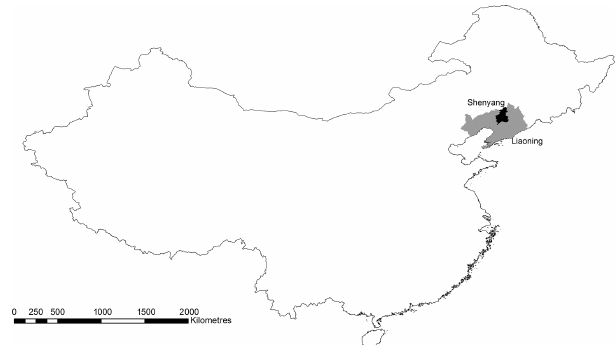
Figure 1. The geographical location of Shenyang, Liaoning Province, and mainland